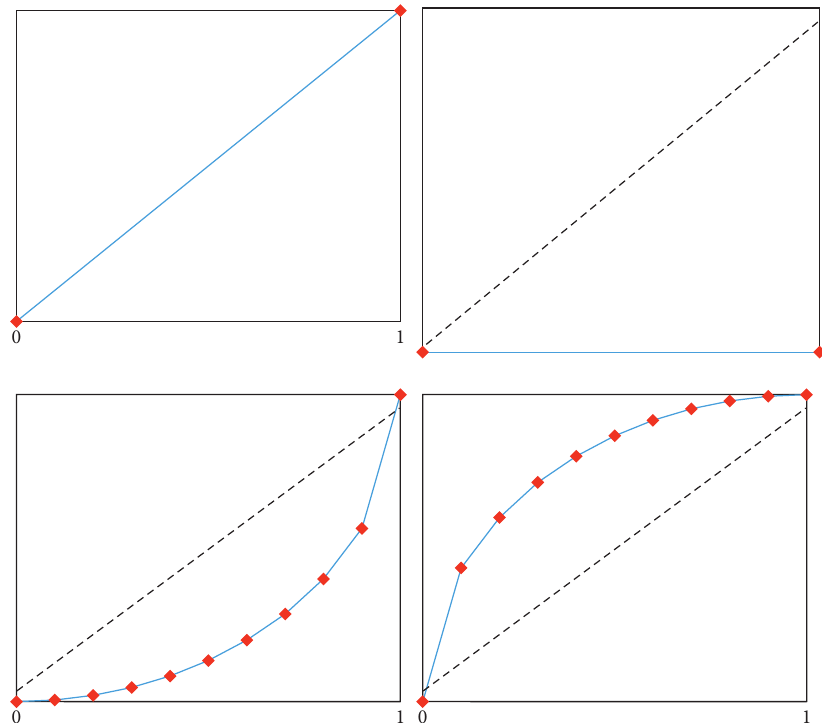
Figure 4: Linguistic value. (a) t ( x ). (b) ct ( x ). (c) Very true. (d) Absolutely true.